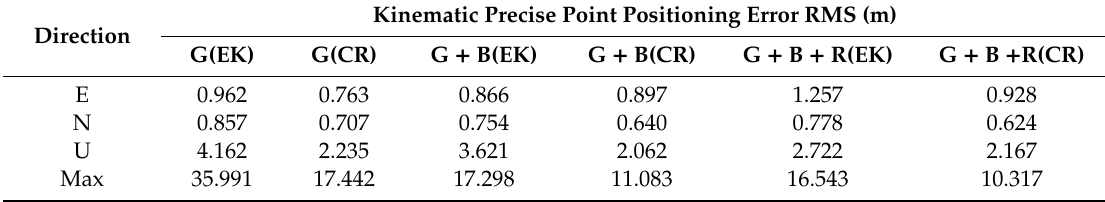
Table 3. RMS of GPS, BDS, and GLONASS kinematic PPP errors in three directions within 100 min. MAX denotes maximum three-dimensional